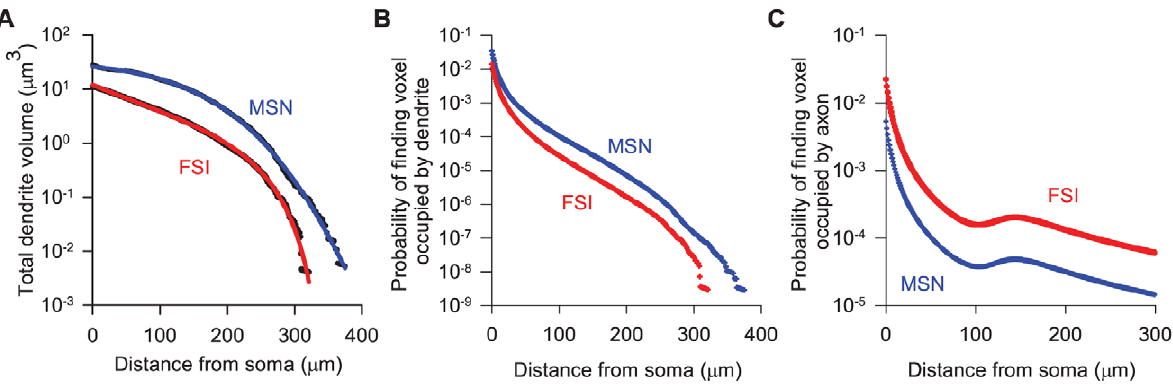
Figure 6. Model predictions for the changes in neurite density and detection probability with distance from the soma. A Model predictions for the total volume of dendrite at a given distance from the soma. The solid lines give the best-fit functions of the form in equation (19). Both this rational function form and the log 10 -transform of the data were necessary to accurately fit the tails of the distributions. B Probabilities for MSN and FSI dendrites, computed directly from the mean total dendrite volume estimates. C Probability for finding an axon-occupied voxel, as given directly by evaluation of equation (16) (shown for the chosen axon-density constant values of j MSN ~ 22 and j FSI ~ 92 ).